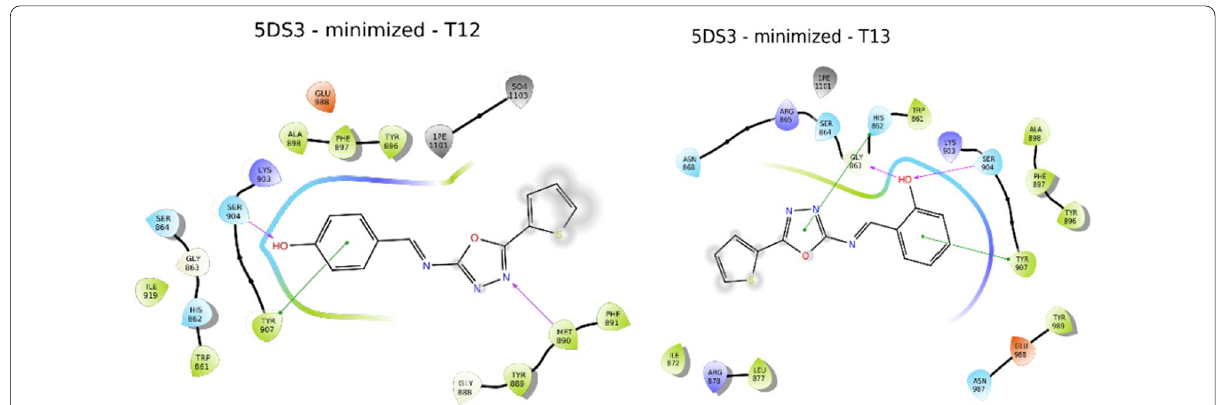
Fig. 2 Ligand interaction of compound T12 and T13 with PARP-1